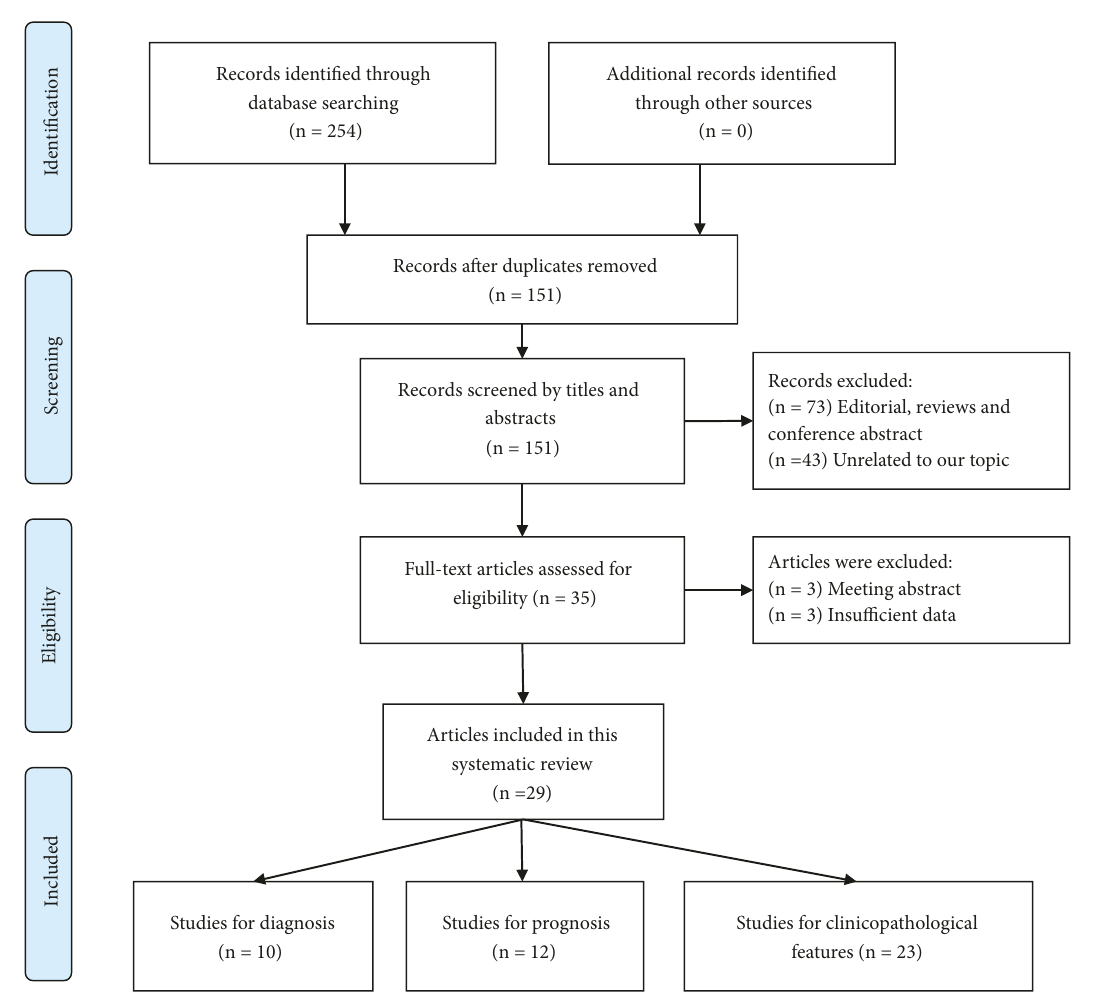
Figure 1: The flow diagram of the study selection